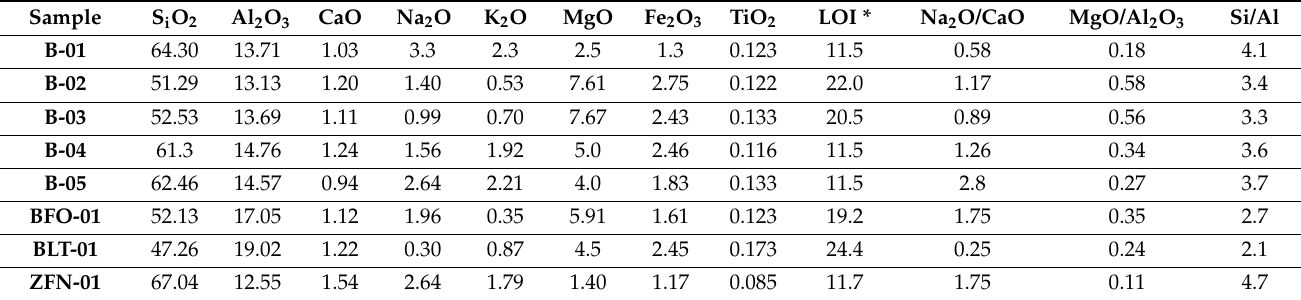
Table 1. Chemical composition of bentonites from the San Jos é –Los Escullos deposit and surrounding areas (% weight). Sample S i O